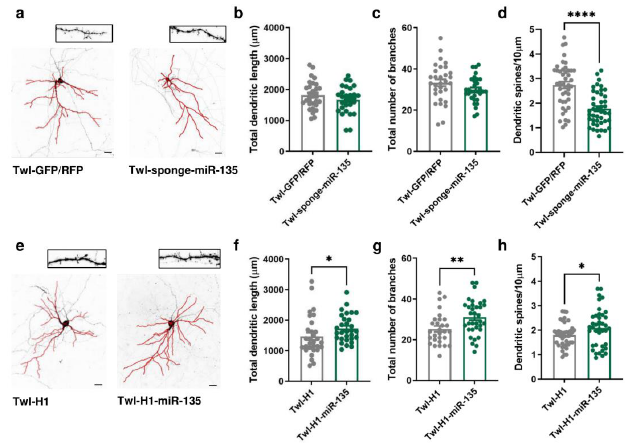
Figure 2. Morphological changes induced by in vitro miR-135a-5p modulation. ( a ) Representative reconstruction of neurons transfected with Twl-GFP/RFP (left) or Twl-sponge-miR-135 (right) and examples of dendritic spines that were analyzed. Scale bar 50 µm. ( b ) Total dendritic length, ( c ) total number of branches, and ( d ) dendritic spine density after downregulation of miR-135a-5p in pyramidal neurons. ( e ) Representative reconstruction of neurons transfected with Twl-H1 (left) or Twl-H1-miR-135 (right) and examples of dendritic spines that were analyzed. Scale bar 50 µm. ( f ) Total dendritic length, ( g ) total number of branches, and ( h ) dendritic spine density after over-expression of miR-135a-5p in pyramidal neurons. ( b – d , g , h ): Student’s t -test, * p < 0.05, ** p < 0.01, **** p < 0.0001; N = 30 – 40 (Twl-GFP/RFP), 30 – 40 (Twl-sponge-miR-135), 30 – 40 (Twl-H1), 30 – 40 (Twl-H1-miR-135). ( f ): Mann – Whitney test, * p < 0.05; N = 30 (Twl-H1), 30 (Twl-H1-miR-135).